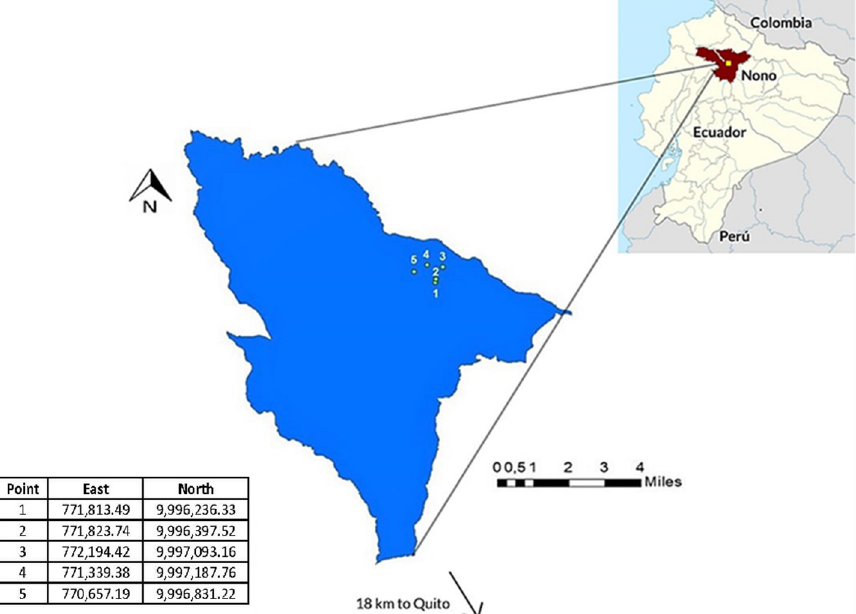
Figure 1. Map of Nono district, Pichincha province, Ecuador. The overall figure illustrates the geographical orientation of Ecuador within Central America. In the expanded map of the inset, the numbers (1–5) indicate the locations where the samples of water were taken, with the Universal Transverse Mercator coordinates of each point listed in the table below.